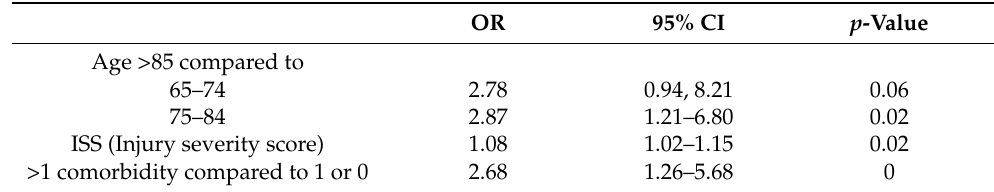
Table 3. Multivariable logistic regression for factors predictive of death (at hospital discharge) among geriatric patients with low-energy blunt trauma ( n =